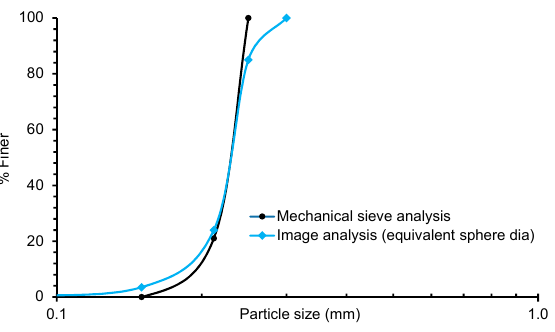
Figure 10. Initial grading obtained from mechanical sieving and image data.